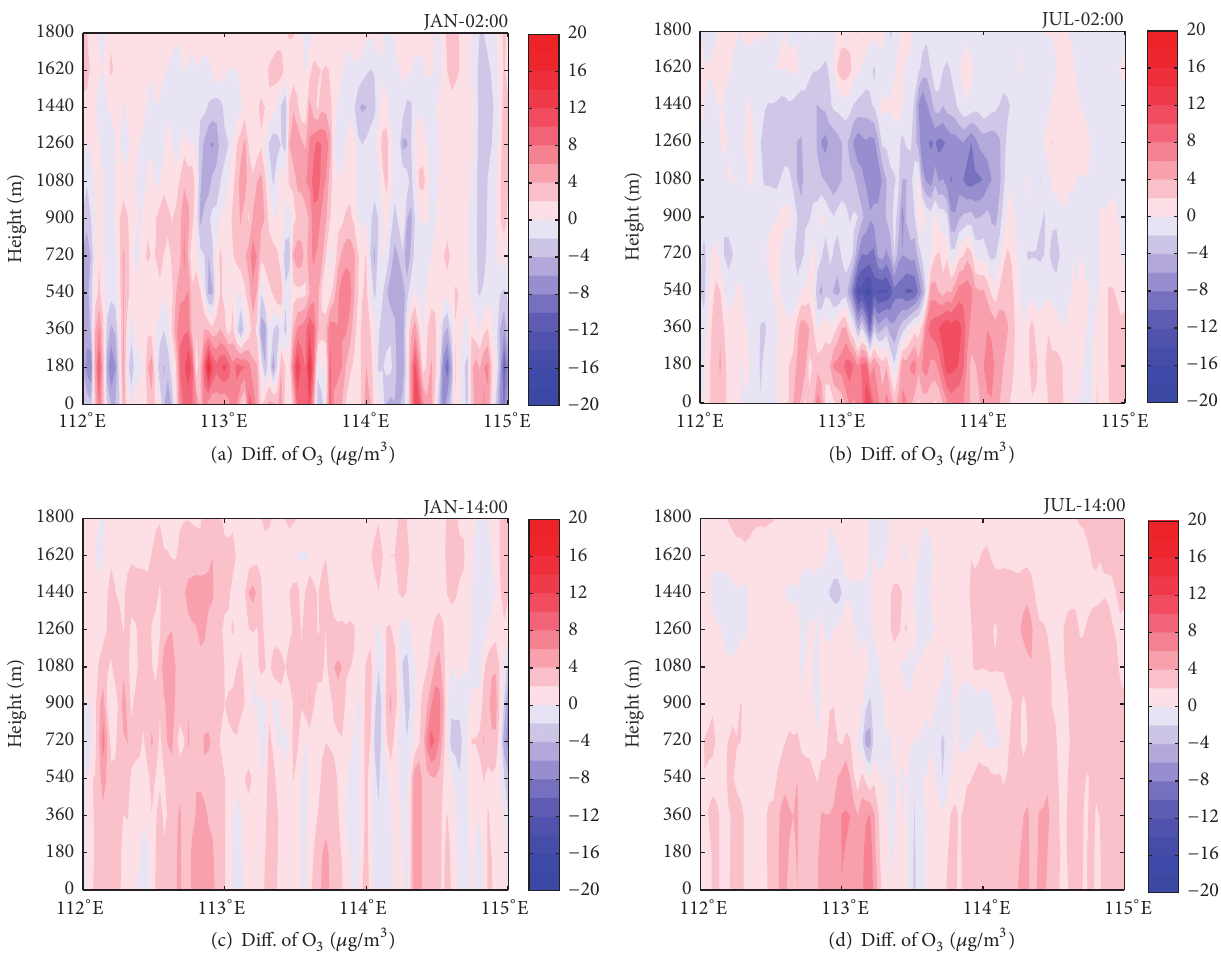
Figure 8: Vertical cross sections of O 3 concentration differences ( 𝜇 g/m 3 ) along 23.5 ∘ N at 02:00 LST (a, b) and 14:00 LST (c, d) between the GLC2009 case and the GLC2000 case (differences = GLC2009 −